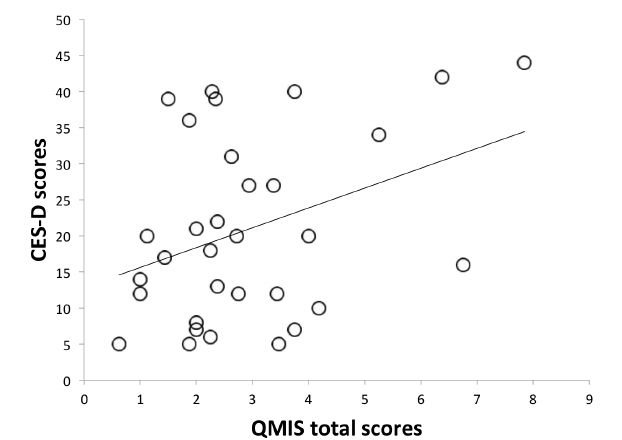
Figure 1. Correlation between CES-D scores and QMIS scores. The CES-D scores and QMIS scores are positively